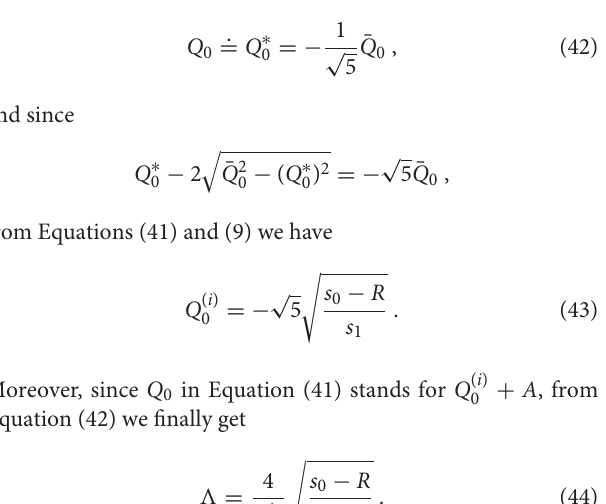
computed in closed form by minimizing the right hand side